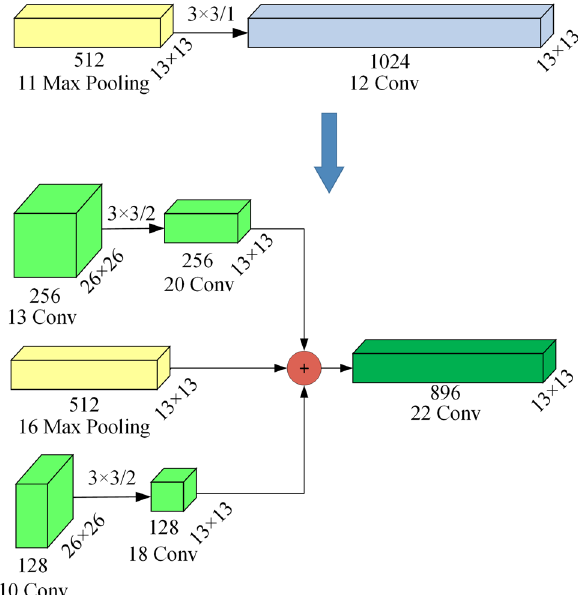
Figure 3. Multi-resolution fusion